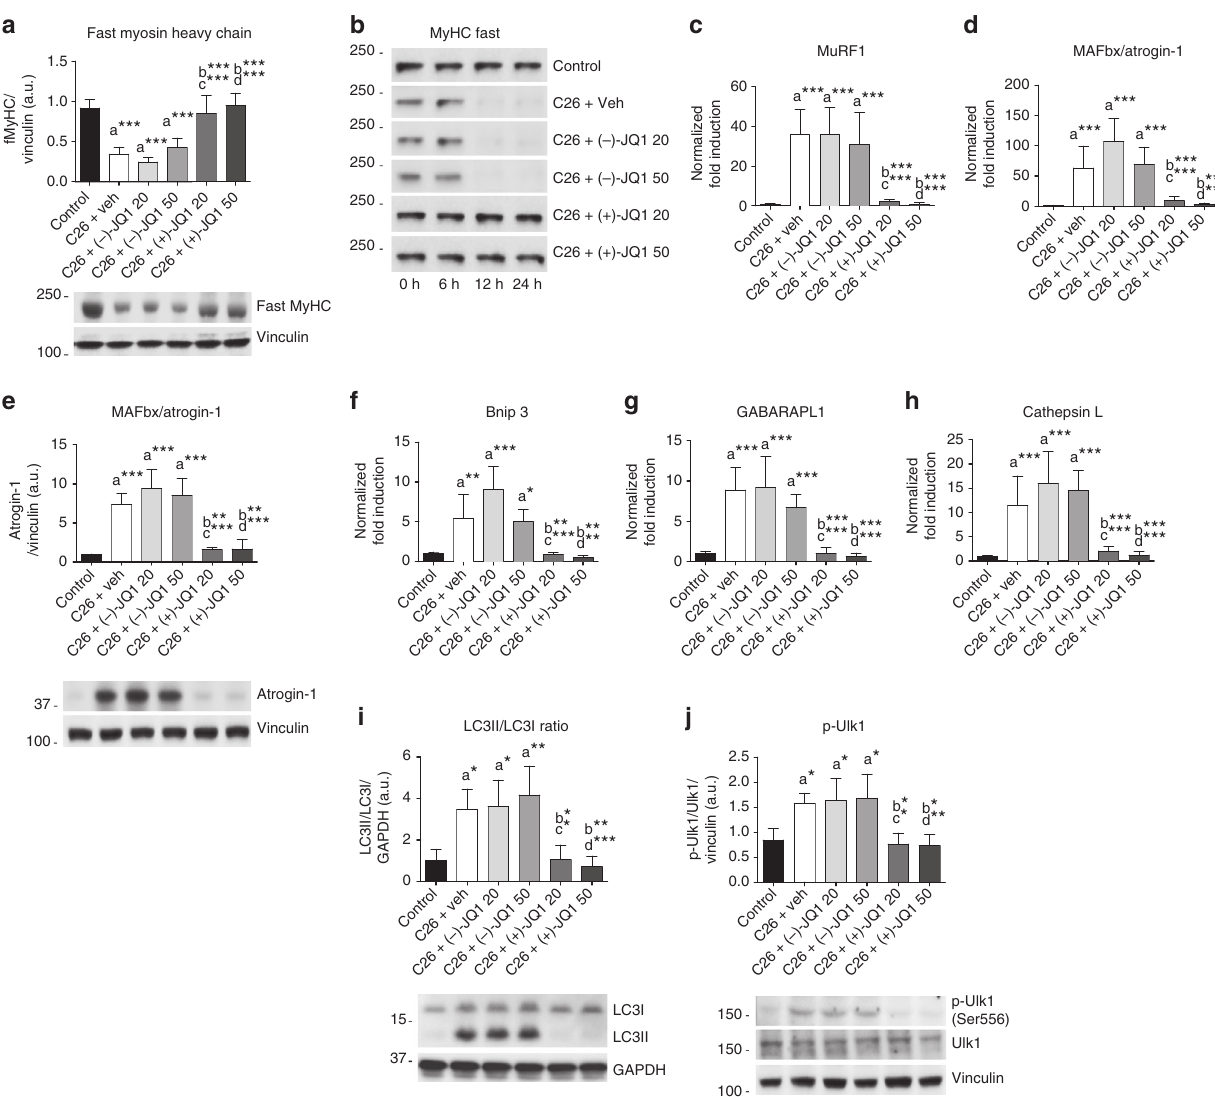
Fig. 3 Muscle proteolysis and autophagy are hindered by JQ1 administration. a Representative immunoblot showing fast myosin heavy chain (MyHC) protein expression in TA whole extracts from the six animal groups. Upper panel shows quanti fi cation of immunoblot bands from four animals per group. Data represent means ± SD. b TA extracts from control and C26-tumor-bearing mice (animals per group: n = 3) were used in an in vitro degradation assay to reveal fast MyHC degradation in control vs. tumor-bearing mice treated with vehicle or JQ1 ( − /+). c , d Total RNA was extracted from TA muscles from control and C26-tumor-bearing mice (animals per group: n = 10) treated with vehicle or JQ1 ( − /+) and expression levels of MuRF1, MAFbx/Atrogin-1 were measured by quantitative RT-PCR. Data represent means ± SD. e Representative western blot of MAFbx/Atrogin-1 on TA whole extracts (animals per group: n = 4). Bands quanti fi cations are shown in the upper panel. Data represent means ± SD. f – h Quantitative RT-PCR of autophagy genes (Bnip3, GABARAPL1, Cathepsin L) from control and C26-tumor-bearing mice. Ten animals were used for each experimental group. Data represent means ± SD. i , j Representative western blot for LC3 and p-Ulk1 in TA extracts of control and C26-tumor-bearing mice (animals per group: n = 4). Upper panel: quanti fi cation of normalized band intensity. Data represent means ± SD. Statistical analysis was performed by using one-way ANOVA followed by Tukey ’ s post hoc test. * p < 0.05; ** p < 0.01; *** p < 0.001. “ a ” indicates statistical signi fi cance compared to control; “ b ” indicates statistical signi fi cance compared to C26 + vehicle; “ c ” indicates statistical signi fi cance compared to C26 + ( − )-JQ1 20 mg/kg/day; “ d ” indicates statistical signi fi cance compared to C26 + ( − )-JQ1 50